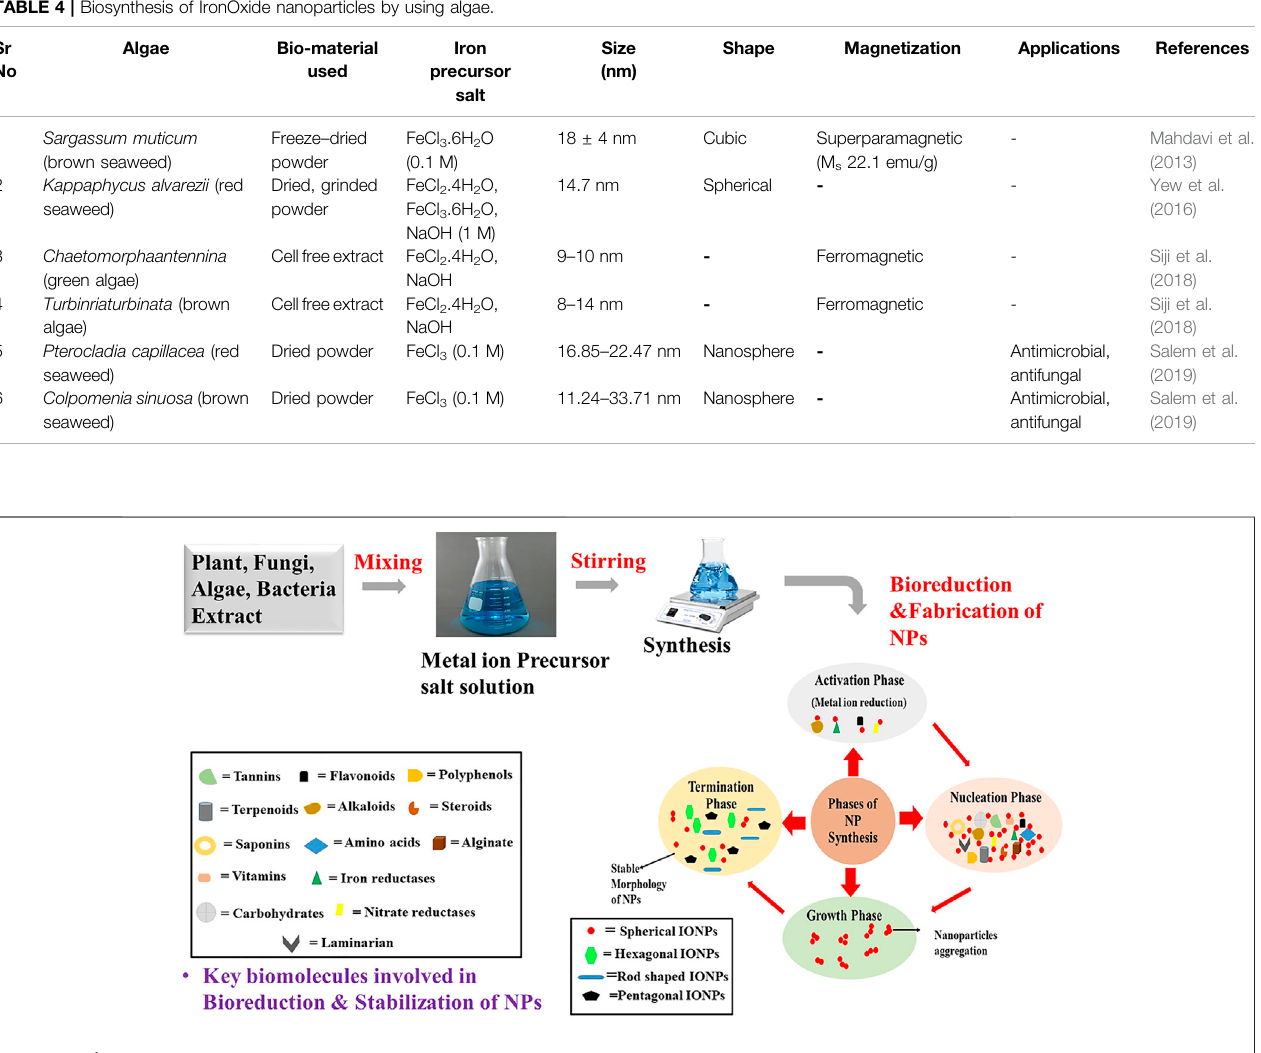
Frontiers in Nanotechnology |